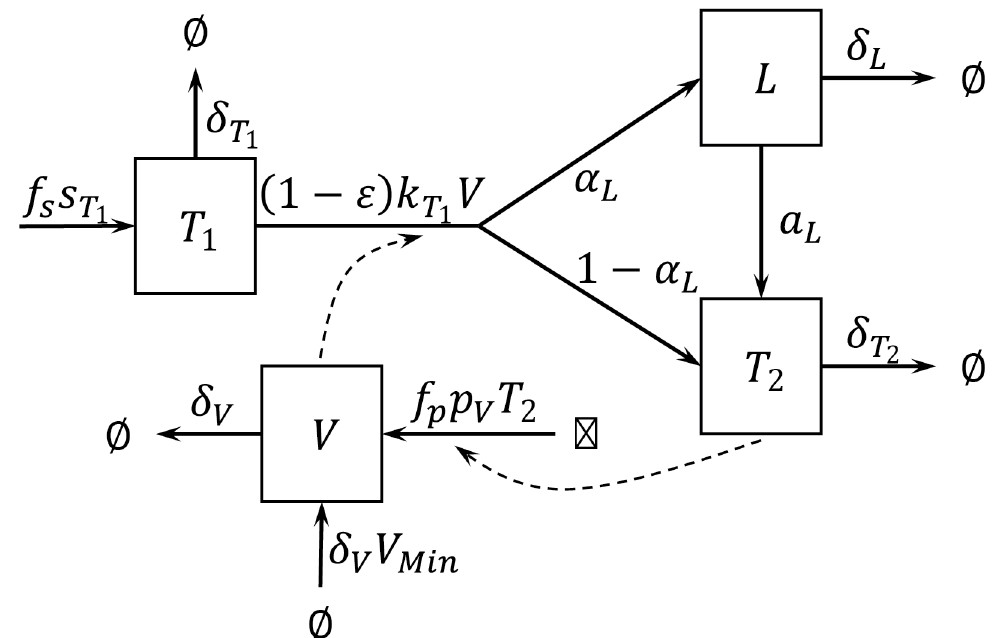
Fig 2. Stock and flow diagram of the basic HIV-1 dynamics model, modified from Rong et al [35]. Uninfected CD4+ T cells (T 1 ) are produced at a rate . Infected CD4+ T cells are produced at a rate k s VT 1 , following mass-action kinetics between free virions (V) and uninfected CD4+ T cells. A small f s T 1 T 1 fraction α L of infections results in latently infected resting CD4+ T cells (L). The remaining fraction results in productively infected activated CD4+ T cells (T 2 ). Latently infected CD4+ T cells are activated into productively infected cells at a constant rate a L . Free virions are produced by productively infected CD4+ T cells at a rate f p p v T 2